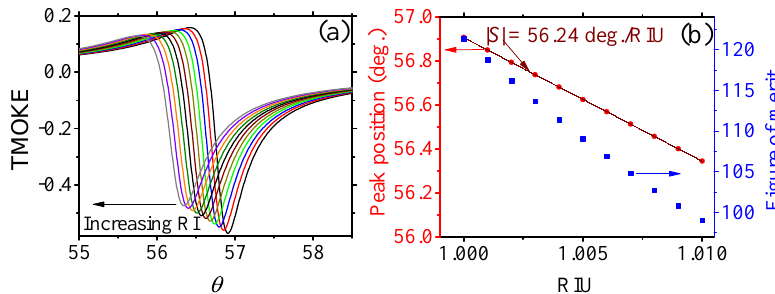
Figure 6. ( a ) TMOKE as a function of θ for an increasing refractive index of the incident medium. The arrow is used to indicate the successive peaks from the highest to the lowest one (associated with the refractive indexes in ( b )). ( b ) The left vertical axis corresponds to the angular peak positions and their linear fitting, with | S | = 56.24 ◦ /RIU, whereas the right vertical axis shows the corresponding FoM associated with each